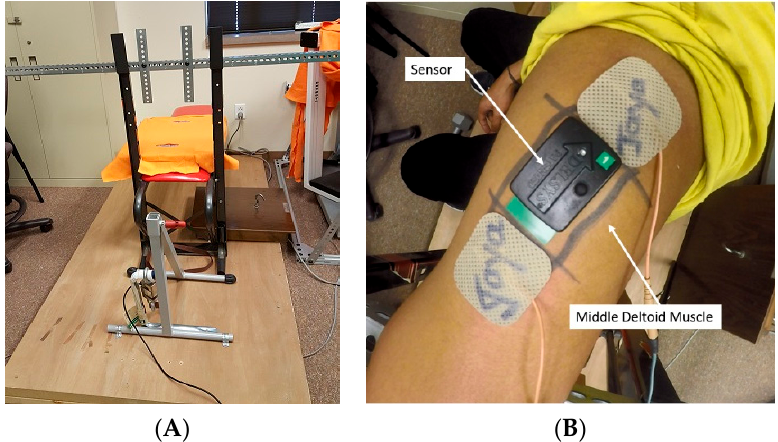
Figure 1. Illustration of the experimental setup: ( A ) experiment fixture; ( B ) stimulation electrode and EMG sensor locations.